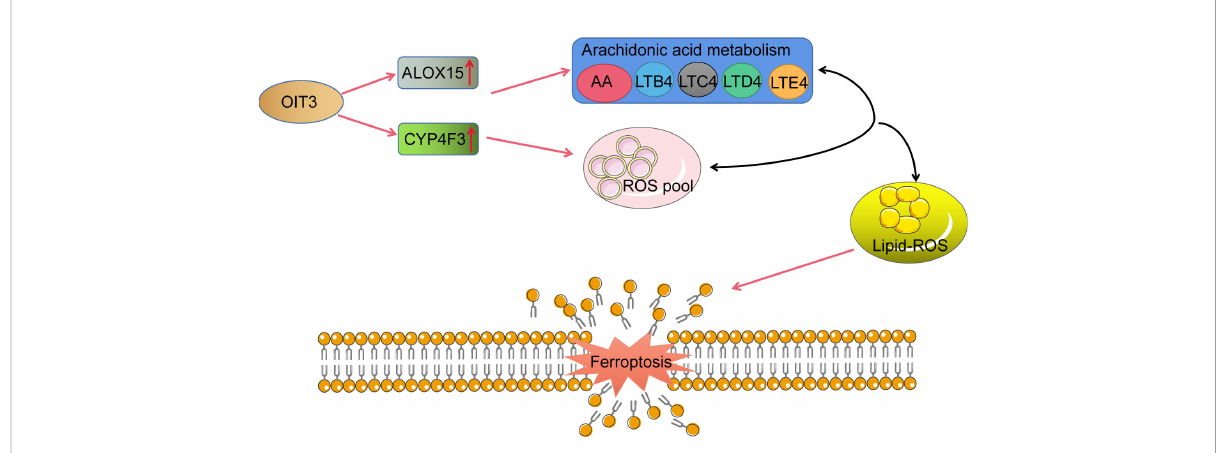
FIGURE 10 The schematic representation of OIT3 signaling in HCC. AA, arachidonic acid; LTB4, leukotriene B4; LTC4, leukotriene C4; LTD4, leukotriene D4; LTE4, leukotriene